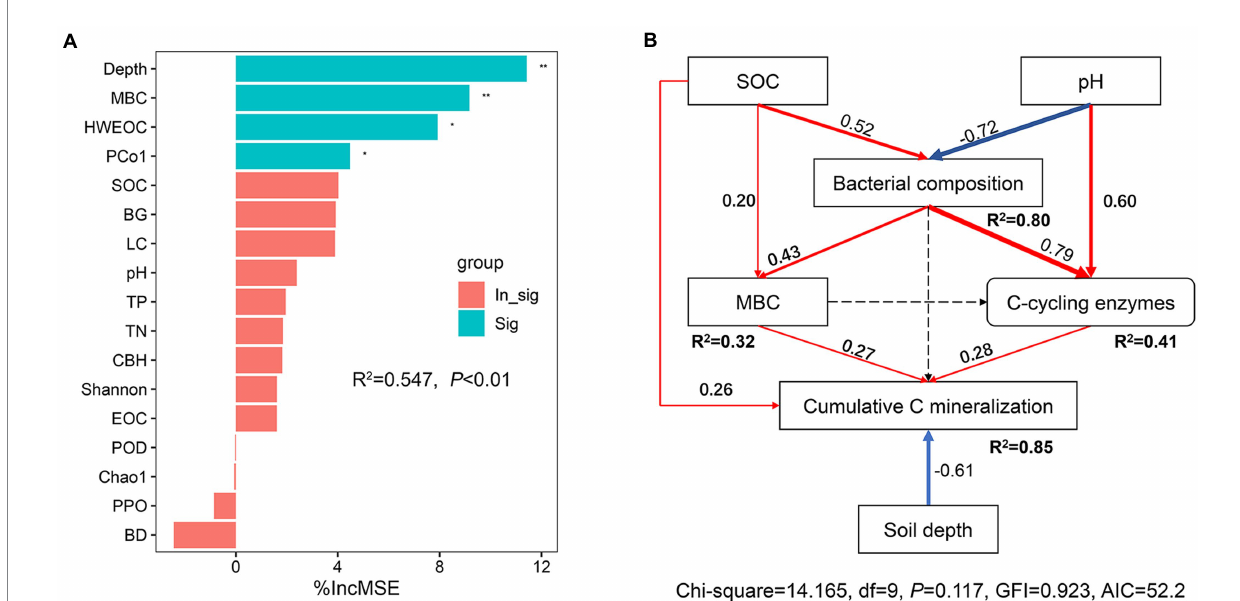
FIGURE 8 (A) Random Forest regression model shows the main factors of SOC mineralization. MSE, is the mean square error. * p < 0.05, ** p < 0.01 on the bar indicated that the associated factor had a significant effect on SOC mineralization. (B) Structural equal model (SEM) analysis of the direct and indirect effects on the response of SOC mineralization to ecological restoration. Red and blue solid arrows indicate positive and negative relationships, respectively. Black arrows represent tested, but not significant paths. The arrow width is proportional to the strength of the relationship. Goodness-of- fit statistics for the model are shown below the model. * p < 0.05, ** p <